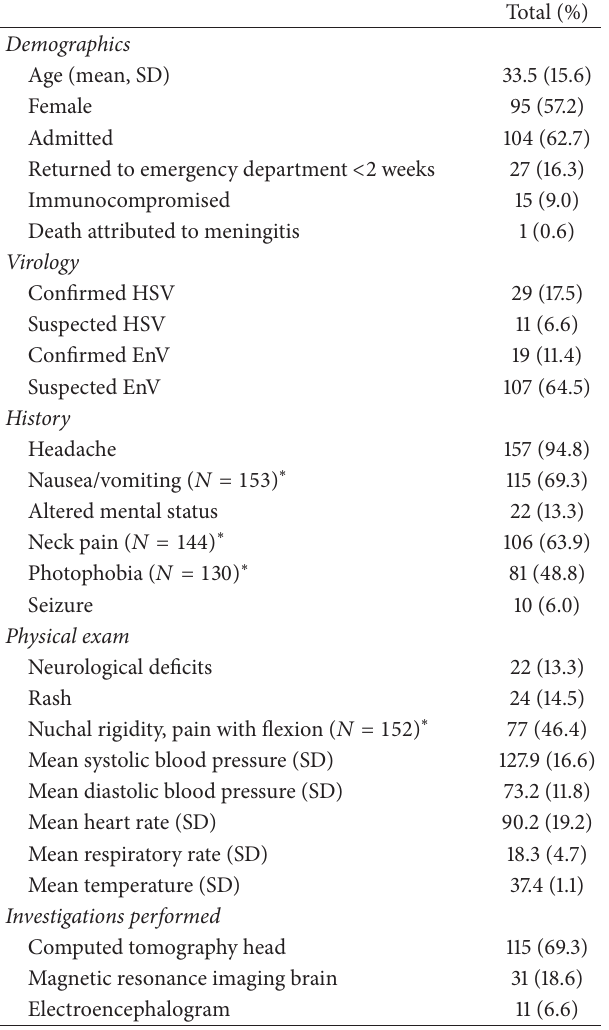
Table 1: Characteristics of all included viral meningitis patients ( 𝑁 = 166